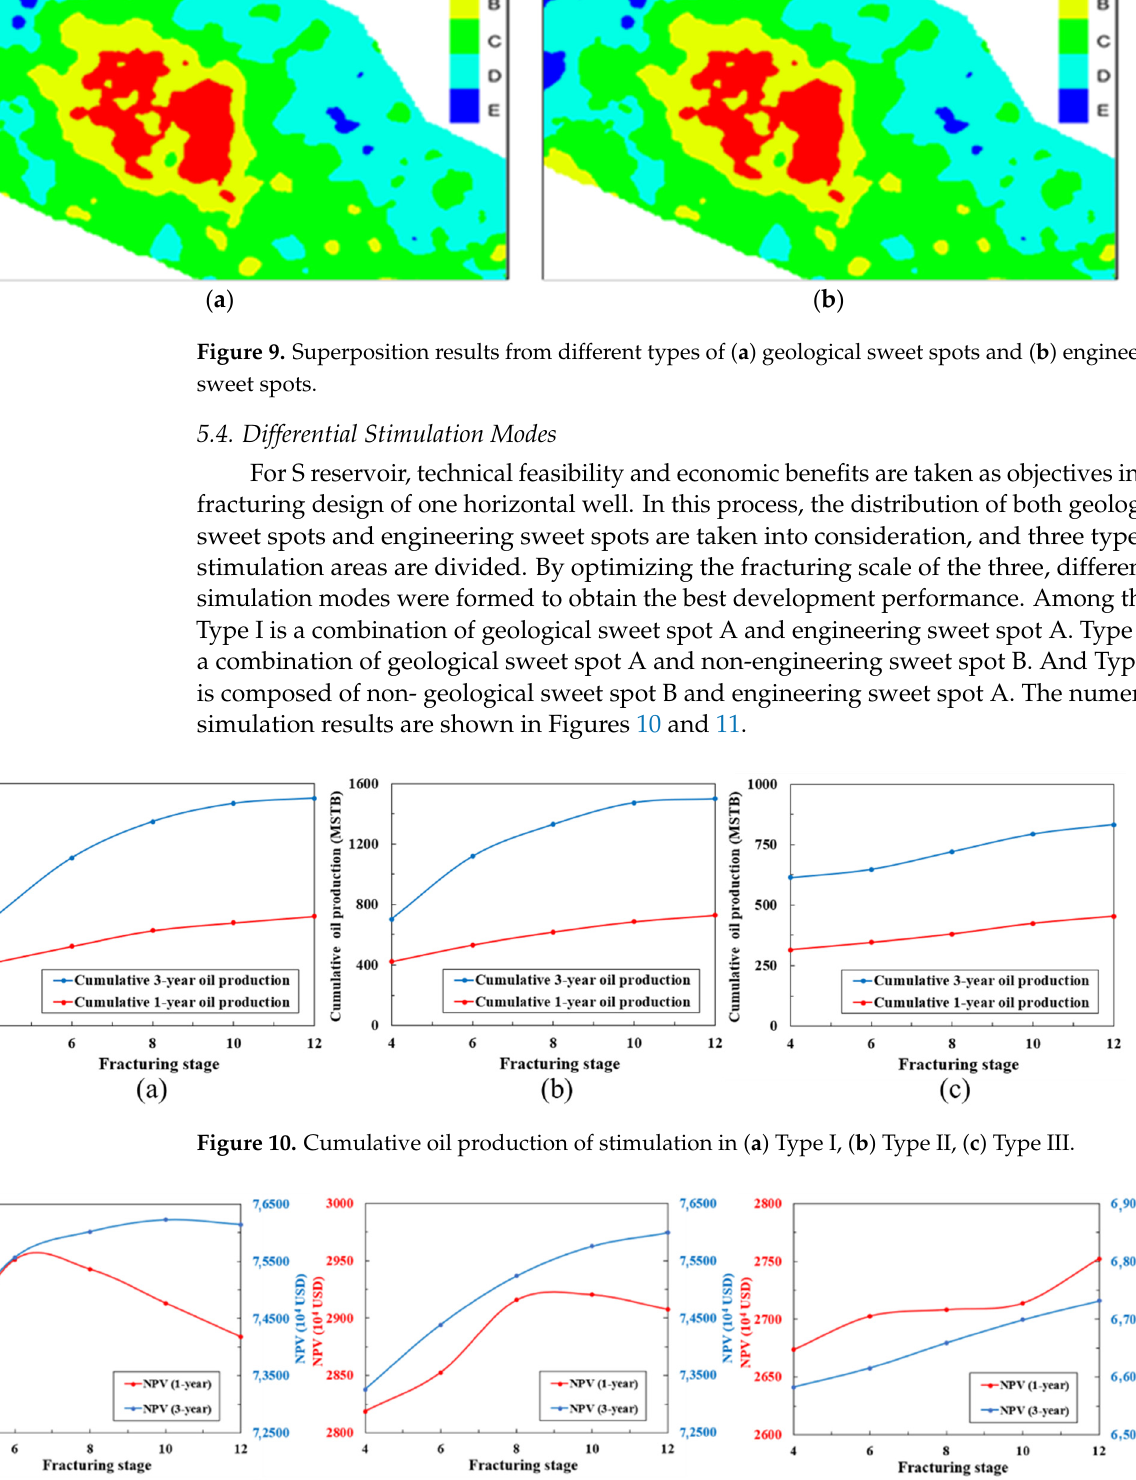
< 14 Table 5. Parameter range of different physical sweet spots. Level